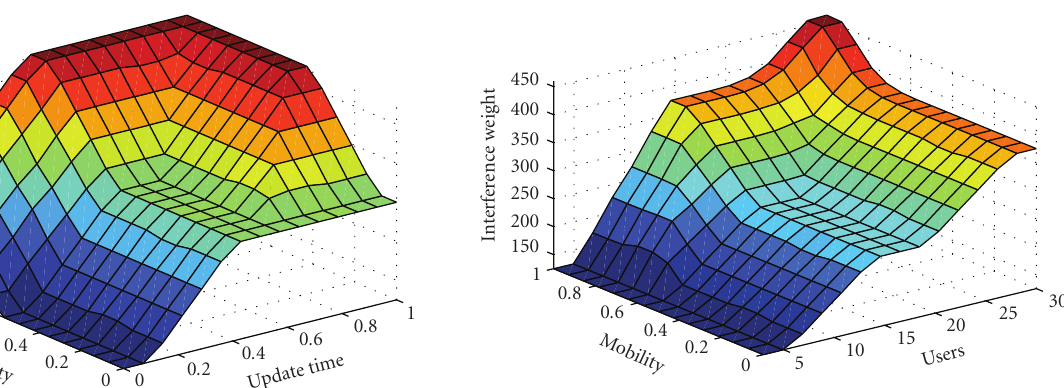
Figure 2: Interference weight as a function of the update interval and the mobility level.